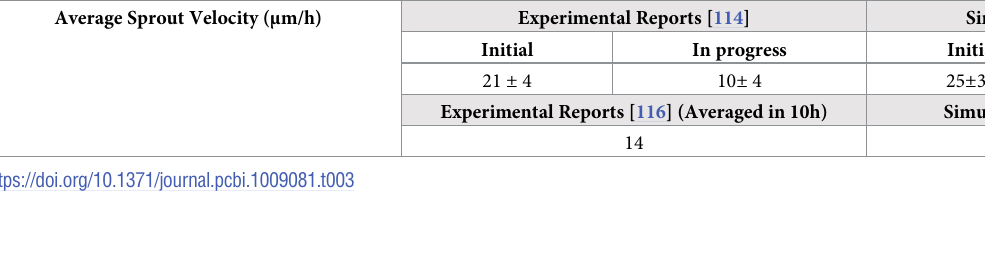
Table 3. Quantitative comparison of simulated average sprout velocity with various experimental observations. Average Sprout Velocity ( μ